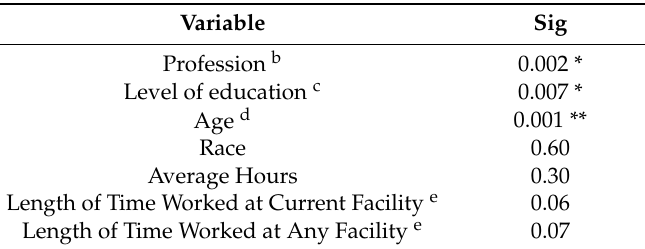
Table 4. Change efficacy a .